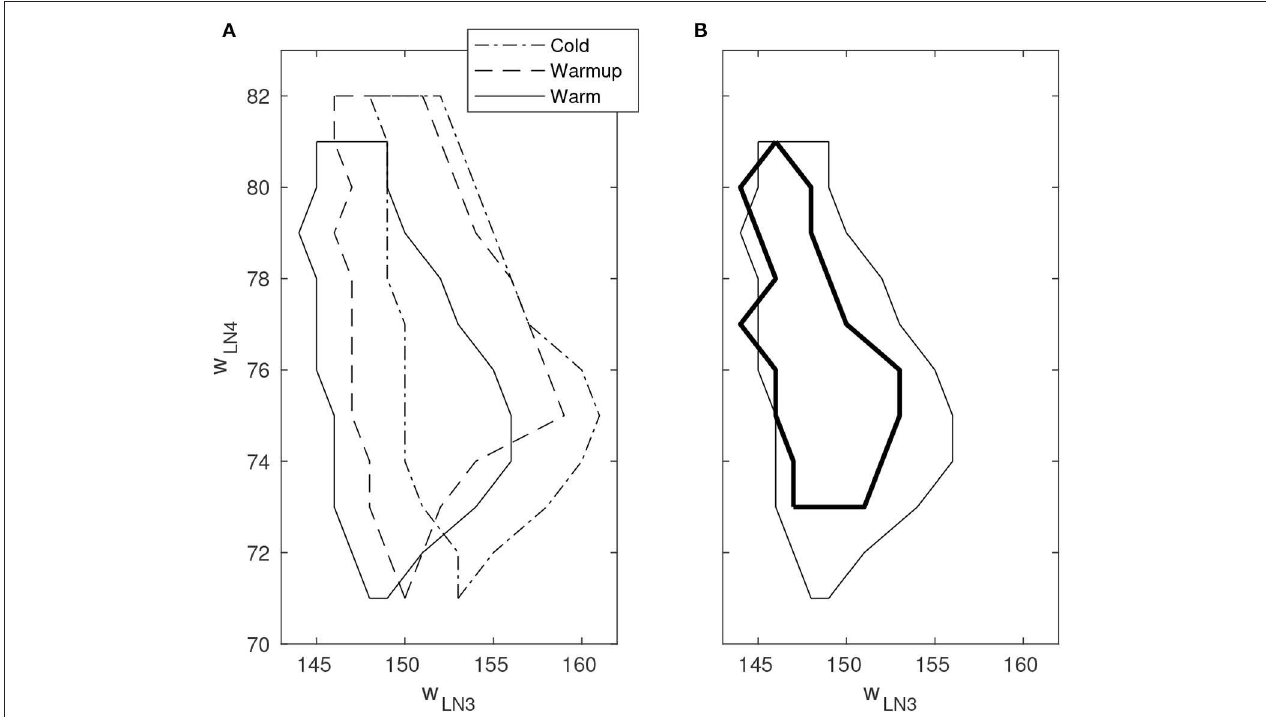
FIGURE 6 | Boundary of correct stimulus classification in synaptic parameter space. Outside the enclosed region, false positives and/or false negatives occur with varying probability. The horizontal and vertical axes indicate the fine integer bias-values of the excitatory synaptic weight for the neurons LN3 and LN4, respectively. Multiple line types indicate experiments performed under different environmental conditions. (A) Movement of the classification boundary observed after several hours of continuous operation from cold startup. The temperature change is likely caused by the FPGA that is enclosed in the system. (B) Shrinkage of the classification boundary in presence of 10% spike-timing noise in the stimulus (bold line). Boundary points are temperature dependent.